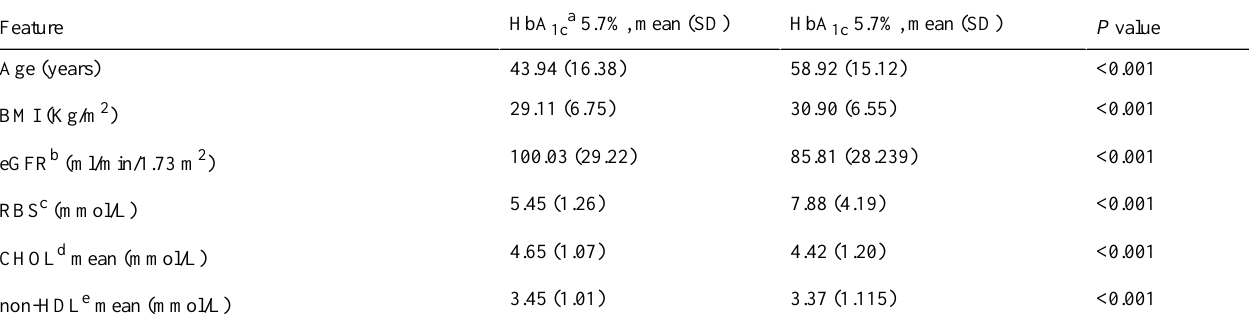
Table 2. Descriptive statistics of the selected features from the King Abdullah International Medical Research Center (KAIMRC) data set.